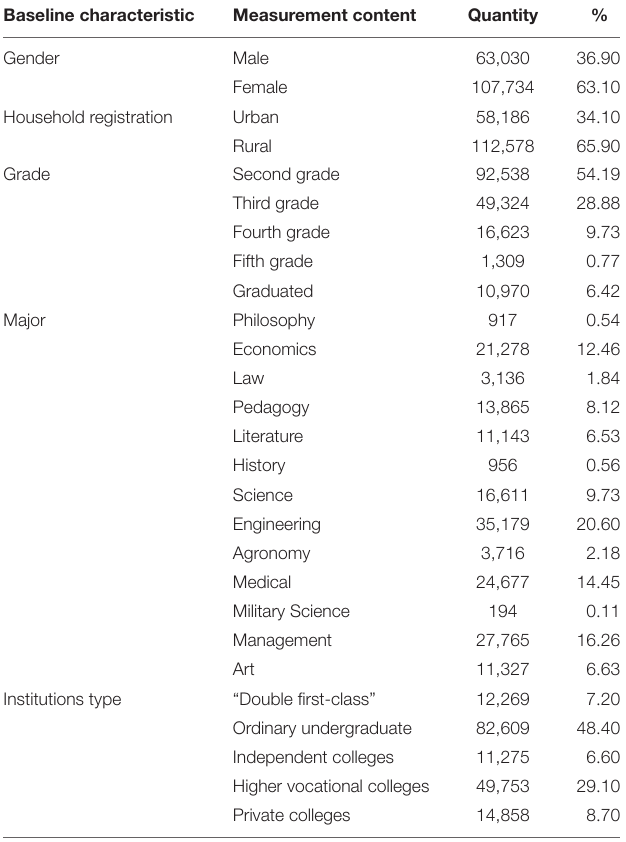
TABLE 1 | Descriptive